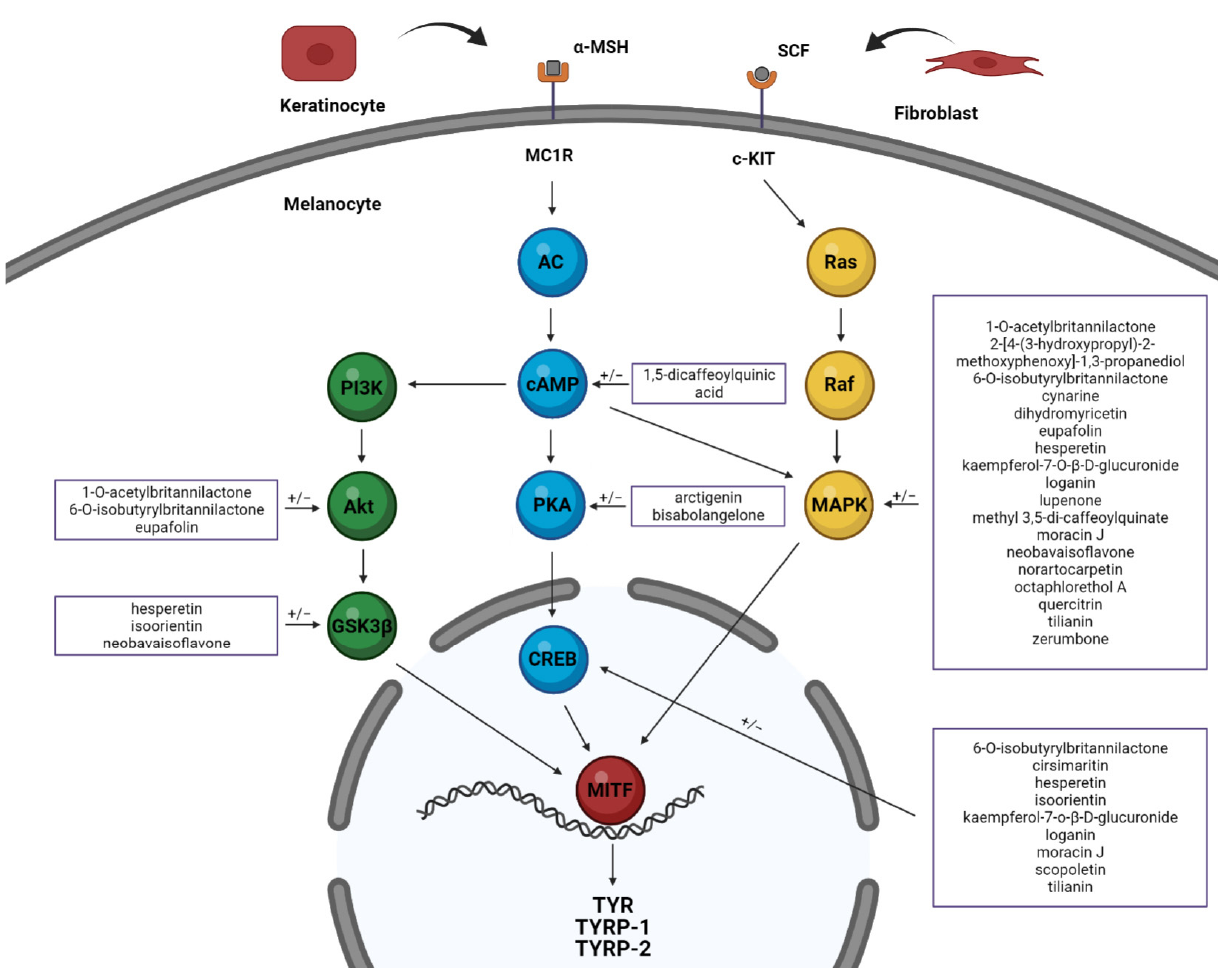
Figure 2. Selected signaling pathways involved in melanogenesis that are modulated by several isolated plant compounds. [Created by